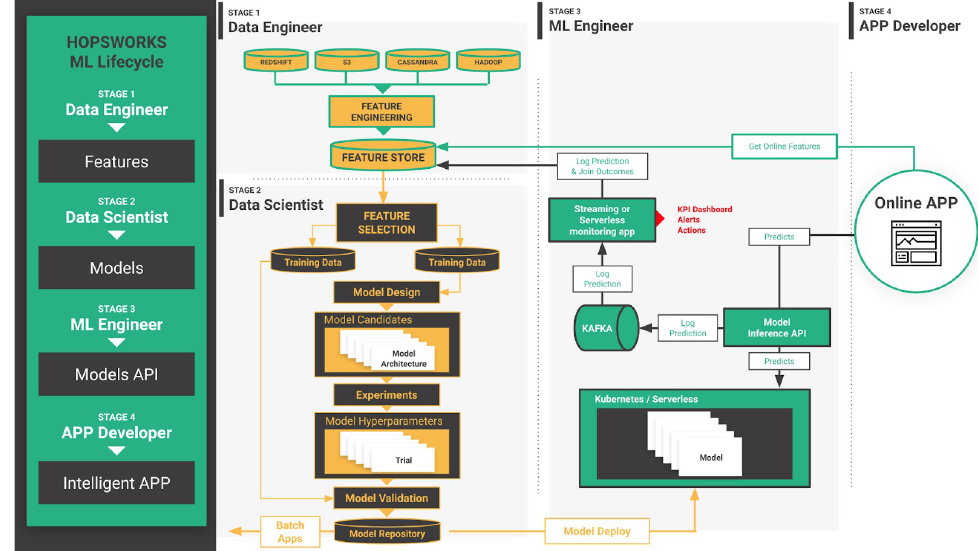
Figure 2. Hopsworks lifecycle of an end-to-end ML/DL